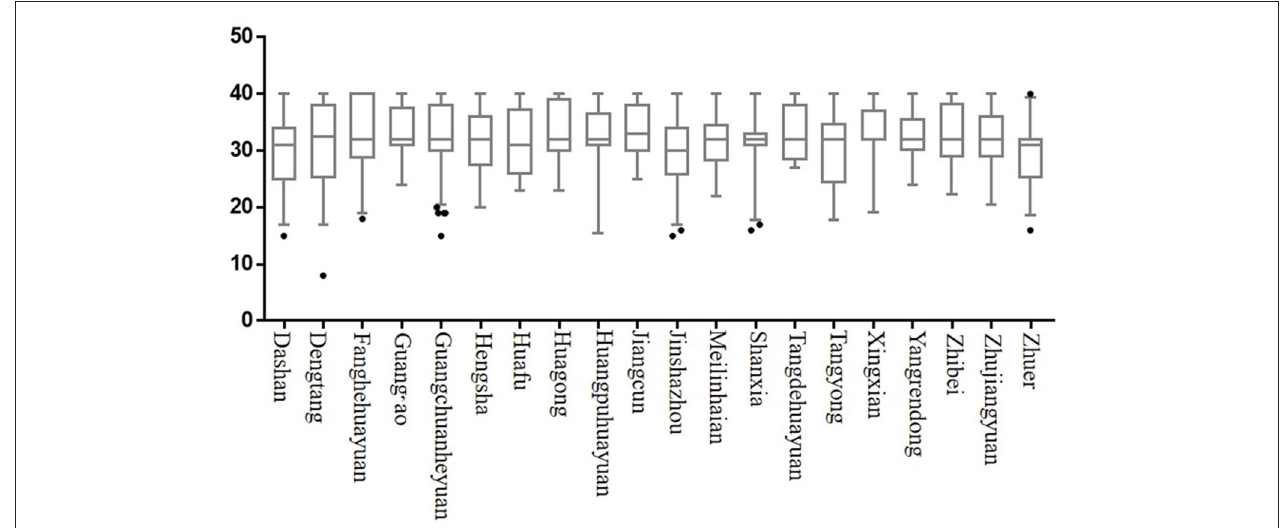
FIGURE 3 | Level of mental health of the older adults in the sample communities.